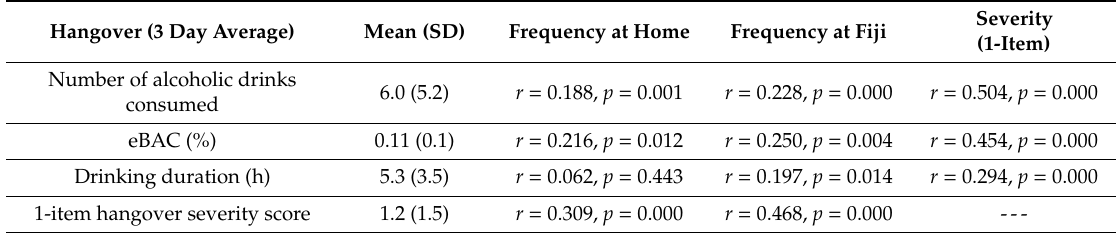
Table 2. The association between drinking variables, hangover severity, and hangover